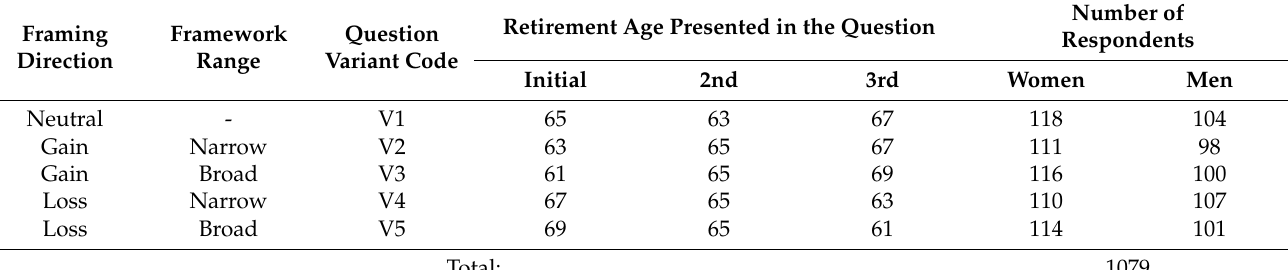
Table 2. Variants of Framing the Decision-Making